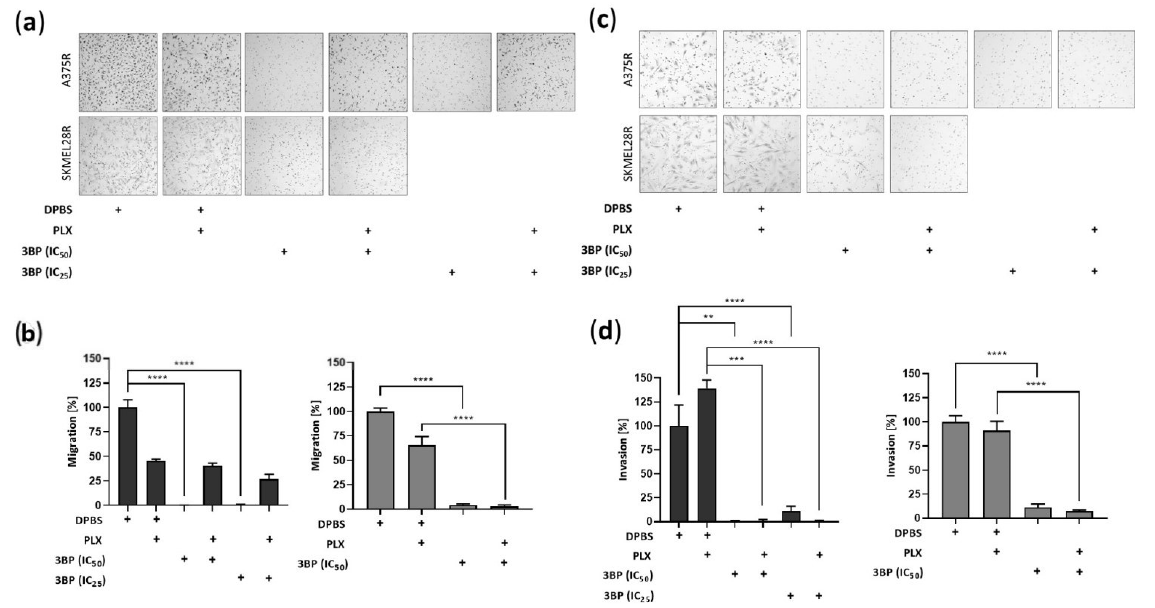
Figure 5. Migration and invasion analysis using the transwell assay in vemurafenib (PLX)-resistant melanoma cells treated with 3-bromopyruvate (3BP) for 24 h. PLX-resistant melanoma cells were treated with IC 25 or IC 50 3BP, either alone or in combination with PLX (4.5 µM for A375R cells and 6.0 µM for SKMEL28R cells), for 24 h. ( a ) representative migratory PLX-resistant melanoma cells stained with hematoxylin and eosin; ( b ) graphic representation of migratory cell count; ( c ) representative invasive PLX-resistant melanoma cells stained with hematoxylin and eosin; ( d ) graphic representation of invasive cell count. Data were normalized to the vehicle control (100%). Dark gray represents A375R cells; light gray represents SKMEL28R cells. The positive signs in the bar charts indicate the presence of a defined treatment. Data represent the mean ± SEM of at least three independent experiments performed in triplicate. ** p ≤ 0.01; *** p ≤ 0.001; **** p ≤ 0.0001.